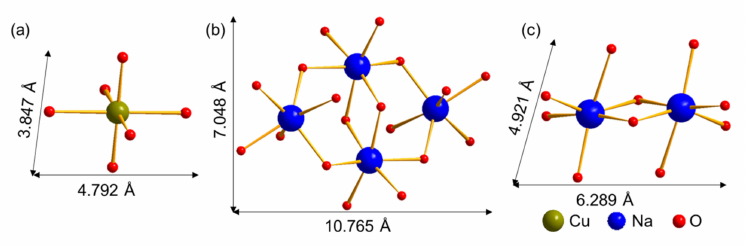
Figure 4. Ball-and-stick representations of coordination environments of linkers for compounds ( a ) 6 and 7 , ( b ) 8 , and ( c ) 9 , showing their different sizes and bridging